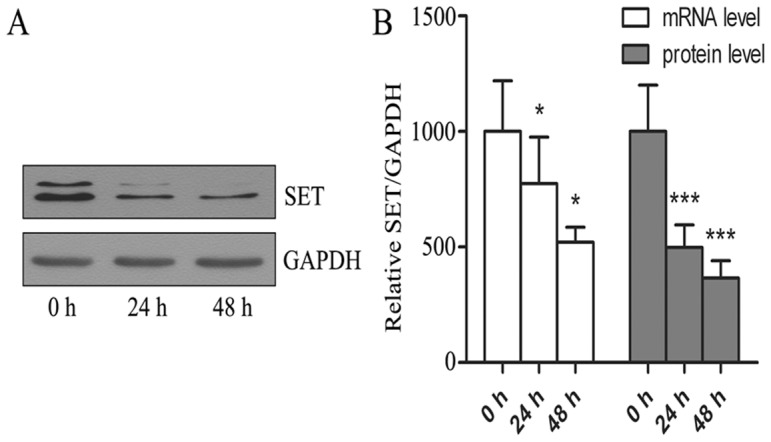
Down-regulation of SET protein and mRNA expression in NB4-R1 cells treated with As4S4.(A) SET protein expression in As4S4 treated NB4-R1 cells, 24 h and 48 h. (B) SET mRNA expression in As4S4 treated NB4-R1 cells, 24 and 48 hrs.